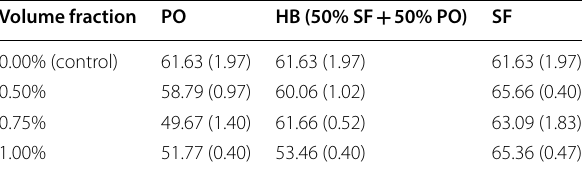
Table 3 Cube compressive strength (MPa).